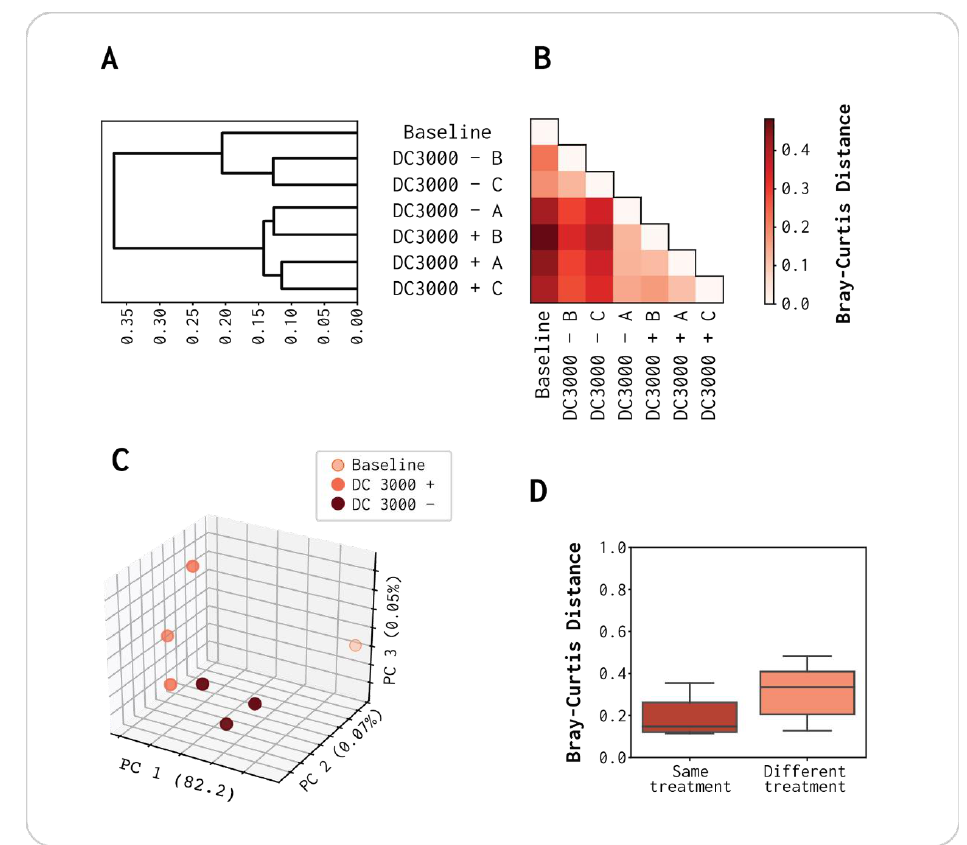
Figure 3. Viral OTU composition of the population present in the three replicates of virome DC3000 +, DC3000 − , and the baseline virome: ( A ) hierarchical clustering of vOTUs based on Bray – Curtis distances; ( B ) pairwise Bray – Curtis distances; ( C ) PCoA plot; ( D ) comparison of treatment incubation of OW in LB media at room temperature for 8 h with or without an overnight culture of DC3000. ANOSIM test statistic = 0.58 ( p -value = 0.085).